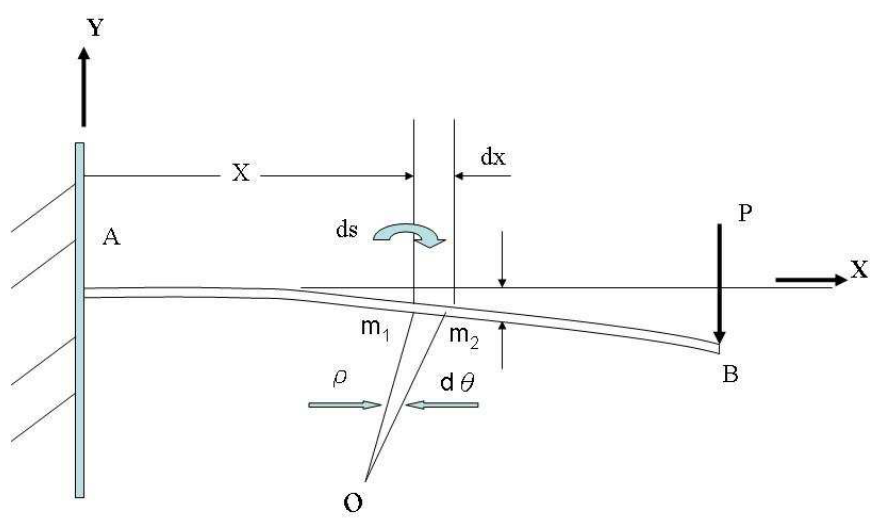
Figure 10. Curvature of a bending beam.